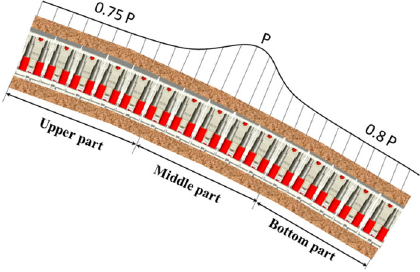
Fig. 10 Mining ground pressure distribution characteristics in steep dipping